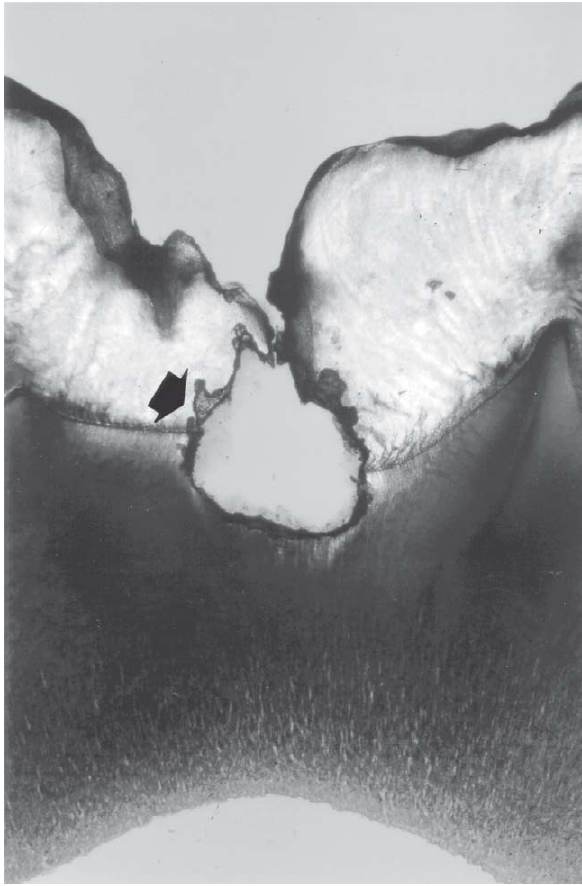
FIGURE 2- Photomicrography (polarized light) of site (arrow) showing the presence of dentinal caries